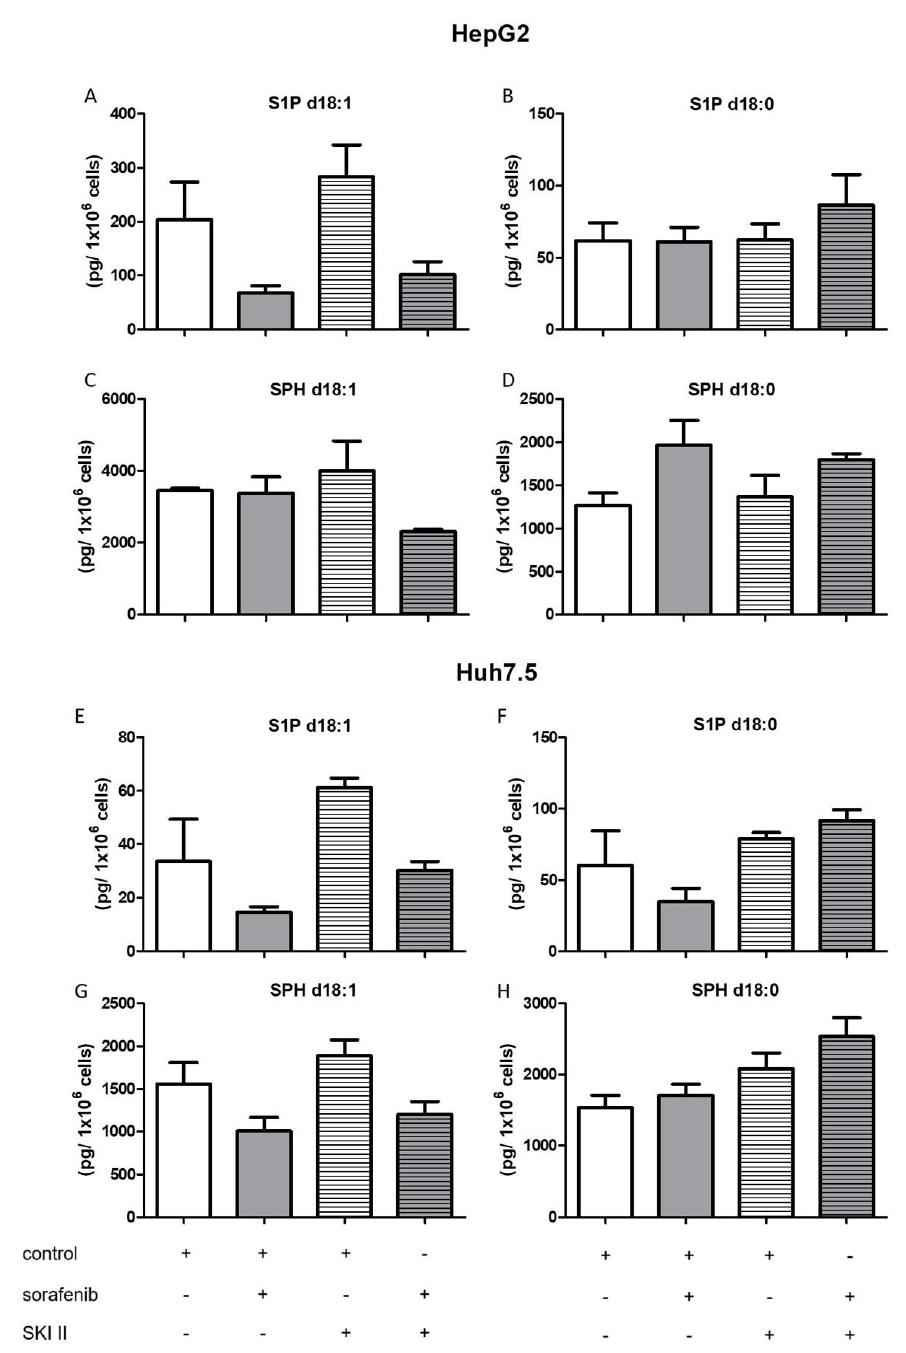
Figure 9. Influence of sorafenib and SKI II on concentrations of S1P and sphingosine in HepG2 and Huh7.5 cells. The lipids were measured by LC-MS / MS. The cells (HepG2 in ( A )–( D ) and Huh7.5 in ( E )–( H )) were treated with or without 10 µ M SKI II for 2 h before the addition of vehicle (control; 0.2% DMSO) or 5 µ M sorafenib and further incubation for 24 h. All results are presented as means ± SEM of three independent experiments.